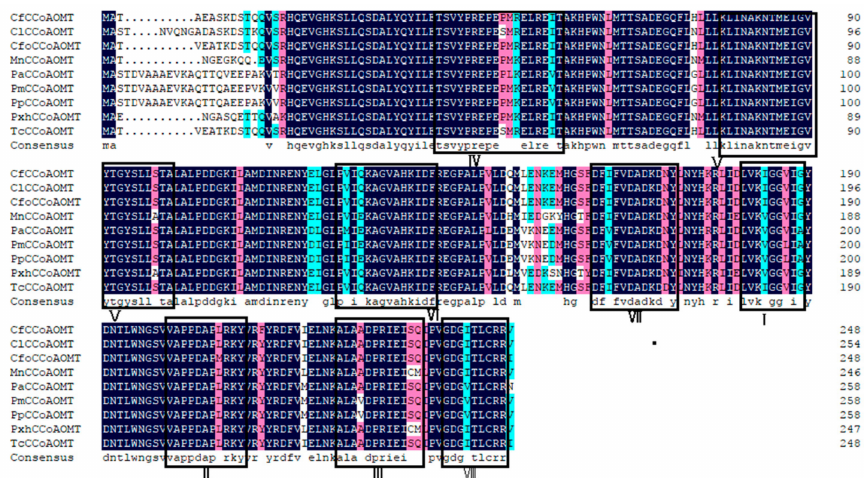
Figure 3. Multiple sequence alignment of the CfCCoAOMT protein using 9 plant species. The species represented by the abbreviations on the left side of the figure and their registration numbers in NCBI are as follows: CfCCoAOMT ( C. fortunei , MK236394), CfoCCoAOMT ( Chamaecyparis formosensis ,